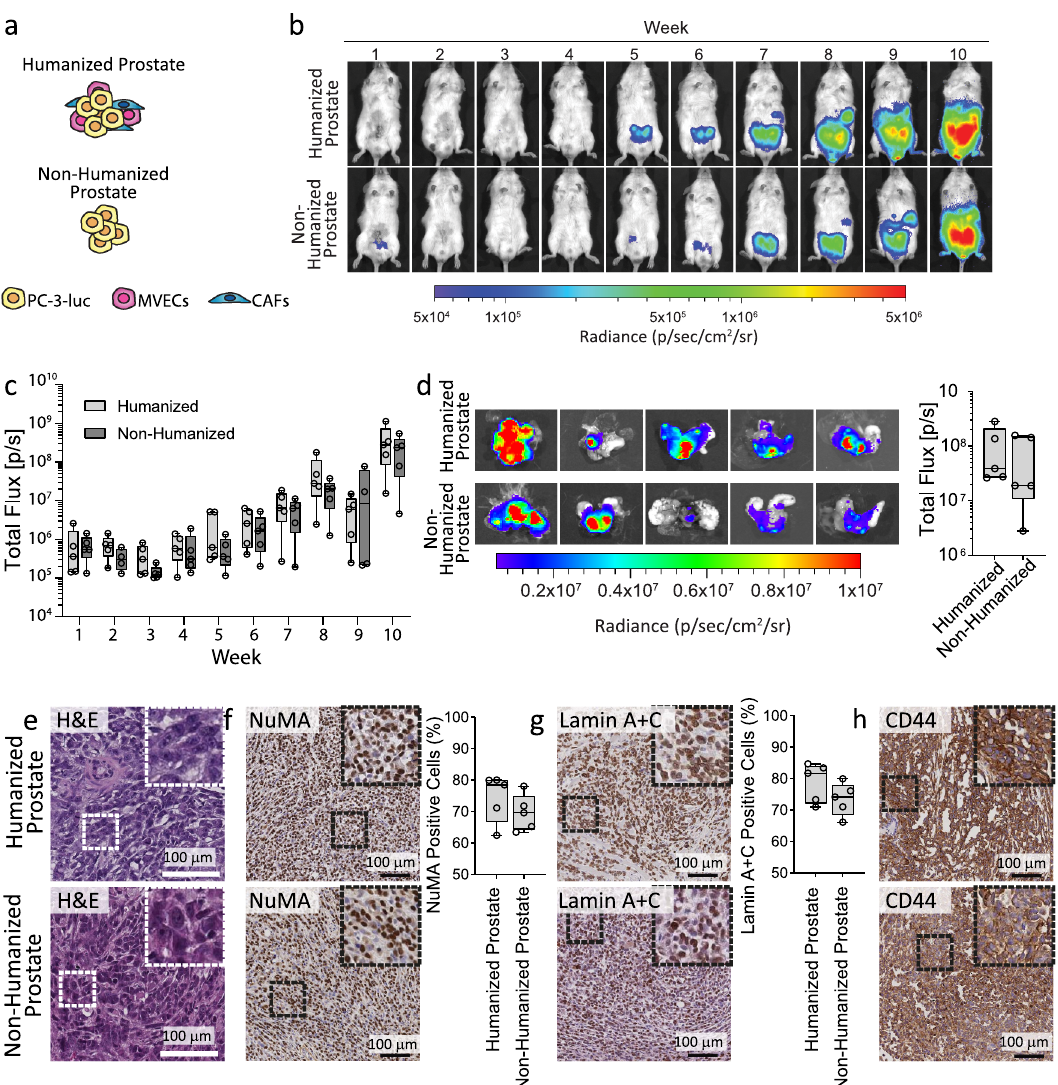
Fig. 3 Primary orthotopic prostate tumor development and characterization. a Intraprostatic injection of the human prostate cells was performed into the dorsal lobe of the murine prostate. b Representative whole body in vivo bioluminescent images (BLI) over the 10 weeks following intraprostatic injection. c Quanti fi cation of in vivo BLI signal in mice with the humanized (light gray box plots) compared to the non-humanized (dark gray box plots) prostate microenvironment ( n = 5 mice per group). d Ex vivo BLI images of murine prostates and correlating quanti fi cation of ex vivo BLI signal from the mouse prostates at the experimental endpoint ( n = 5 prostates per group) reveals that there are no signi fi cant differences between the groups using a Mann − Whitney U Test. e Hematoxylin and eosin (H&E) staining of the primary tumor. Immunohistochemistry staining for ( f ) NuMA and ( g ) Lamin A + C using antibodies that react with human but not murine tissues was performed. Images were captured from three sites of the tissue section, and the percentage of human cells relative to total cells was quanti fi ed and averaged per prostate sample ( n = 5). Data were analyzed using an unpaired t -test and no signi fi cant differences were found. h CD44 immunohistochemistry was performed as an additional marker for human cells. The scale bars represent 100 µ m. Data represented in box plots depict the median, fi rst and third quartile, minimum and maximum, and is overlaid with individual data